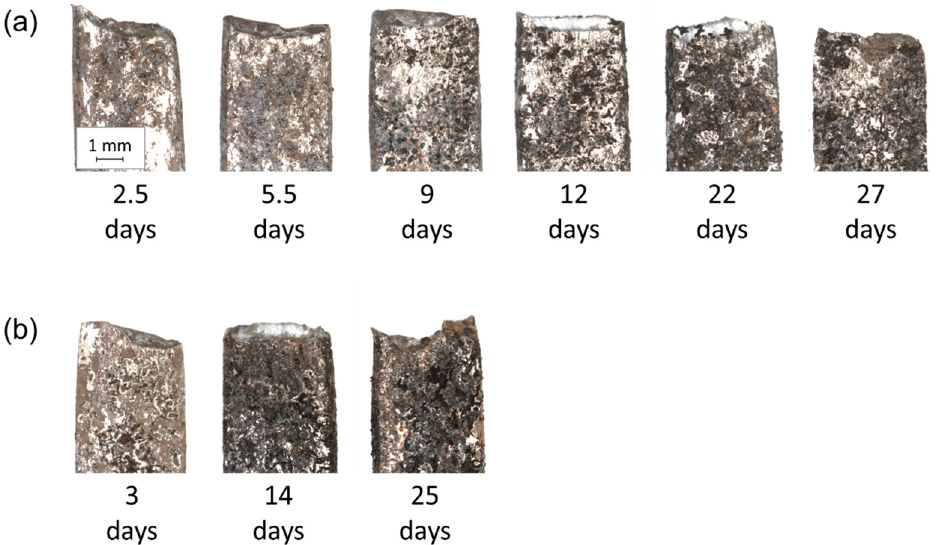
Figure 6. Selected photographs of fractured Corroding ( a ) and Annealed ( b ) tensile specimens exposed in humid air at 85% RH for indicated time.